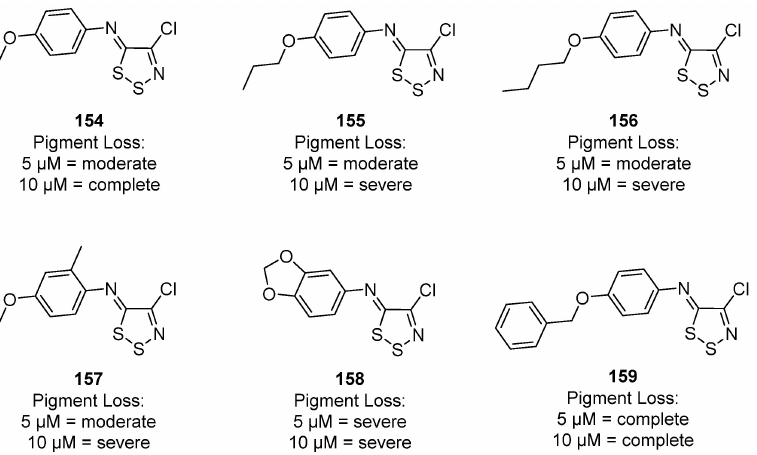
Figure 37. 1,2,3-dithiazoles demonstrating In vivo pigment loss in Xenopus laevis